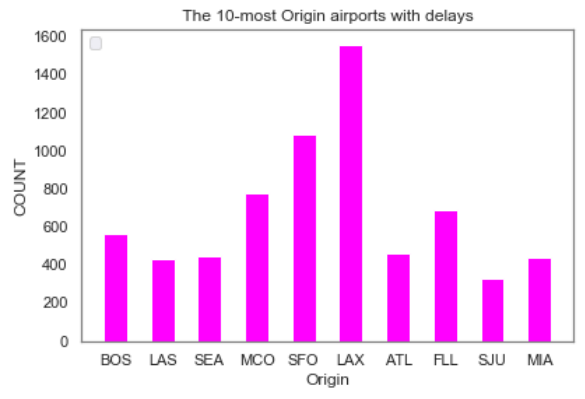
Fig. 7. The10-most delayed airports of departure Table 3. Evaluation metrics with tuning Algorithm Accuracy Precision